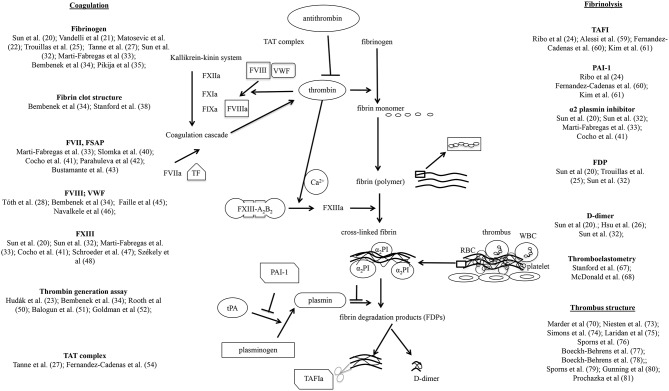
Simplified scheme demonstrating the main elements of coagulation, fibrinolysis, and thrombus formation, depicting publications that investigated the relationship of these elements with the outcome of thrombolytic therapy applied in acute ischemic stroke. α2PI, α2 plasmin inhibitor; FVII, factor VII; FVIIa, activated factor VII; FVIII, factor VIII; FVIIIa, activated factor VIII; FIXa, activated factor IX; FXIa, activated factor XI; FXIIa, activated factor XII; FXIII, factor XIII; FXIIIa, activated factor XIII; FXIII-A2B2, plasma (tetramer) form of factor XIII; PAI-1, plasminogen activator inhibitor-1; RBC, red blood cell; TAFI, thrombin-activatable fibrinolysis inhibitor TAFIa, activated thrombin-activatable fibrinolysis inhibitor; TAT complex, thrombin-antithrombin complex; TF, tissue factor; tPA, tissue plasminogen activator; VWF, von Willebrand Factor; WBC, white blood cell.